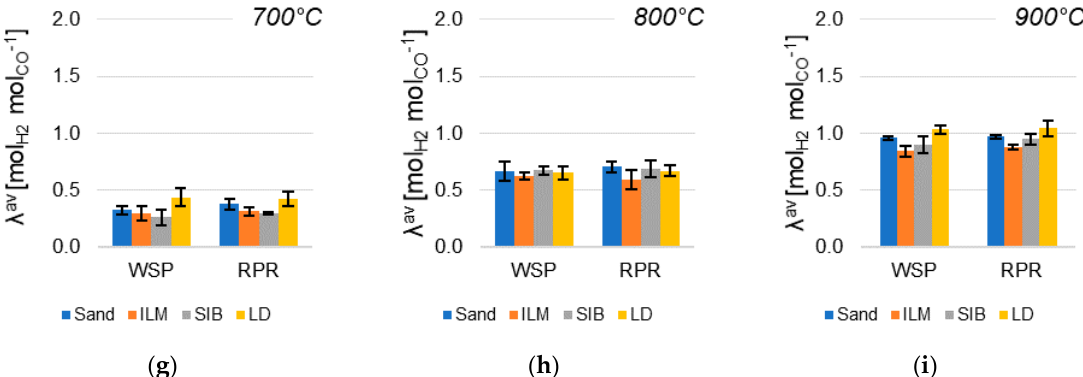
Figure 4 . Experimental results of devolatilization tests as functions of temperature, kind of biomass, kind of bed material: integral-average gas yield ( η av , Equation (1)) at 700 °C ( a ), 800 °C ( b ), 900 °C ( c ); integral-average carbon conversion ( χ avC , Equation (3)) at 700 °C ( d ), 800 °C ( e ), 900 °C ( f ); integral-average H 2 /CO molar ratio ( λ av , Equation (4)) at 700 °C ( g ), 800 °C ( h ), 900 °C ( i ) .